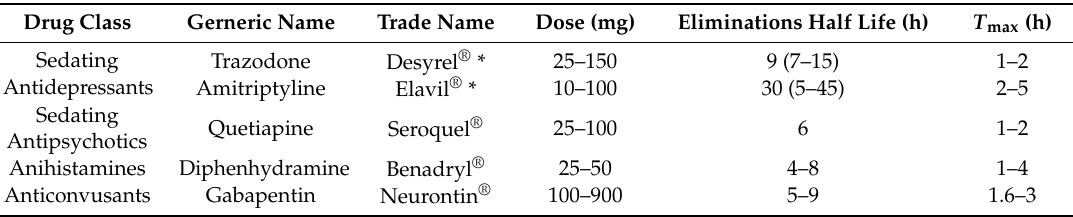
Table 3. Off-label medications for